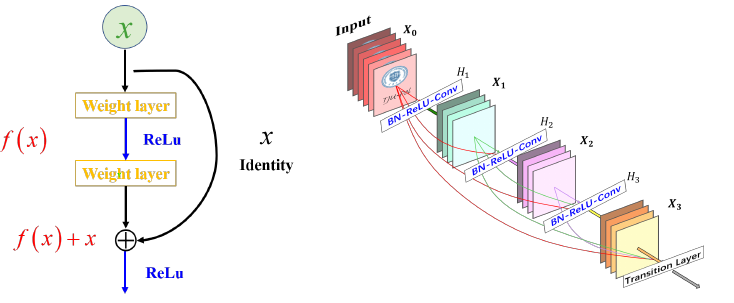
Figure 10. ( Left ) Residual block. ( Right )